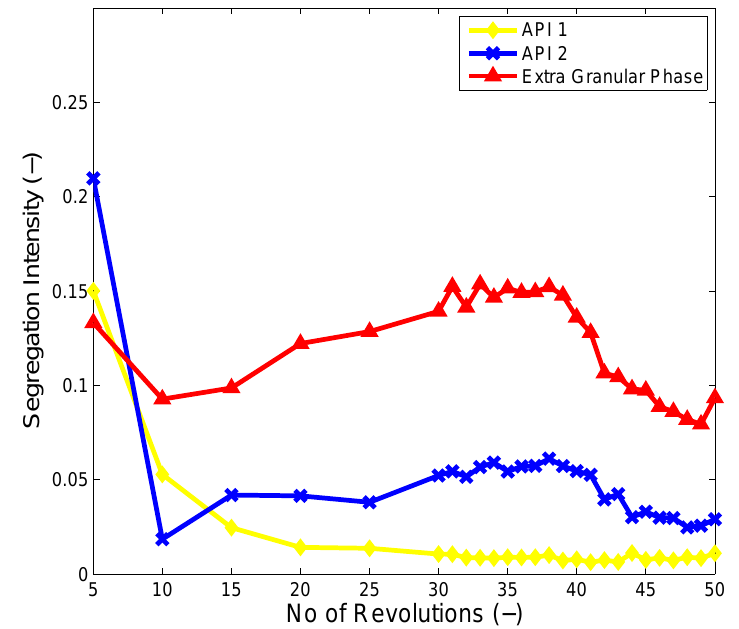
Figure 9. Intensity of segregation vs. the number of